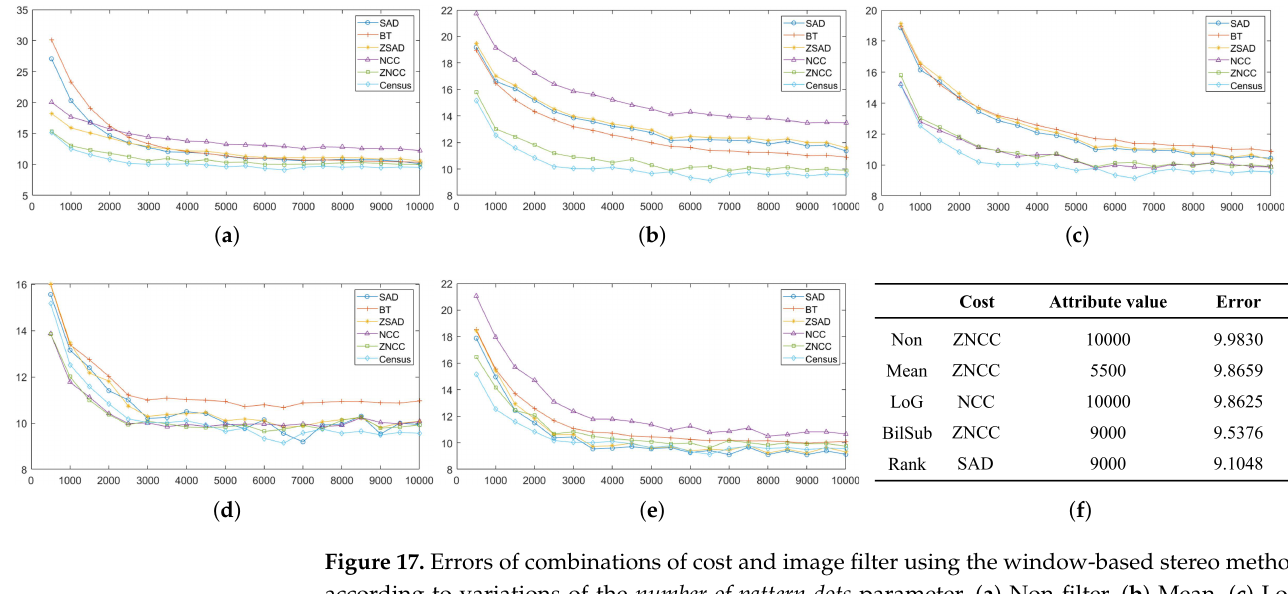
Figure 17. Errors of combinations of cost and image filter using the window-based stereo method, according to variations of the number of pattern dots parameter. ( a ) Non-filter. ( b ) Mean. ( c ) LoG.